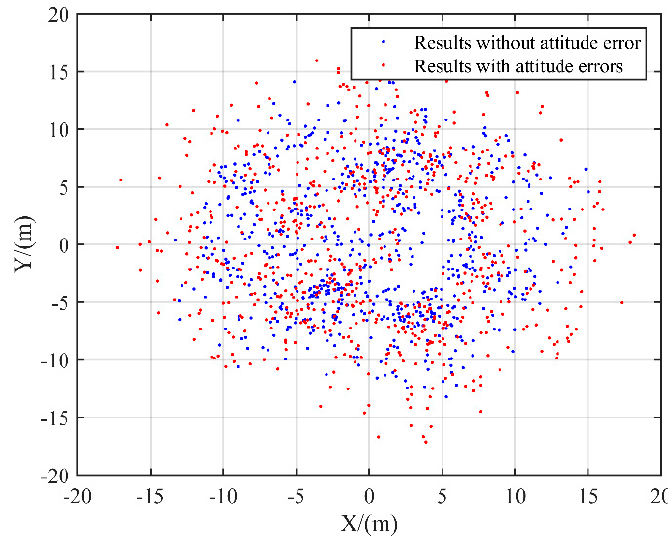
Figure 8. Comparison of the results of the two experiments.